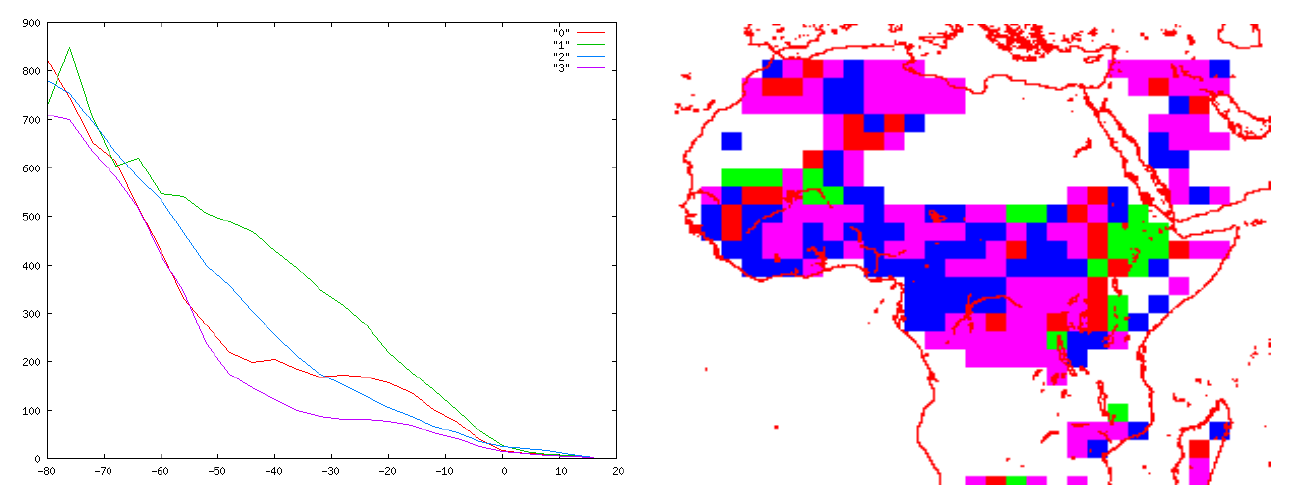
Fig. 7a. Pre-onset period: mean probability function for classes 0, Figure 7.a. Pre-onset period: mean probability function for classes 0, 1, 2, 3. Temperature is coded in 1, 2, 3. Temperature is coded in degree C. degree C.